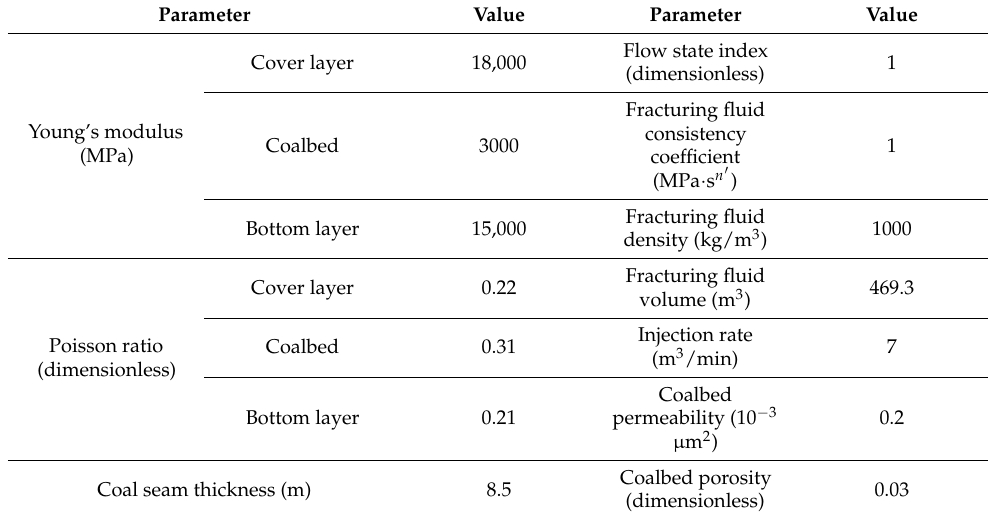
Table 1. CBM formation properties and treatment